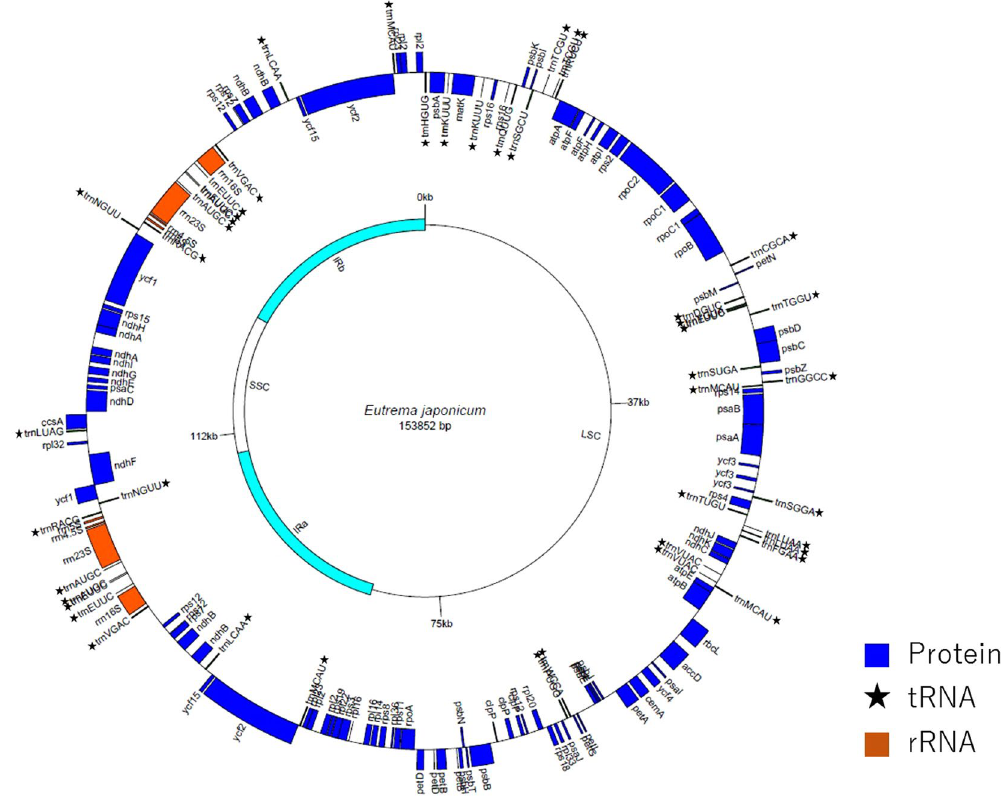
Figure 1. Gene map of Eutrema japonicum ‘Fujidaruma’ chloroplast genome. The genes lying outside the outer circle are transcribed in a counter-clockwise direction, whereas genes inside are transcribed in a clockwise direction. Colors and star marks denote the different functional gene groups. LSC: large single copy, SSC: small- single-copy, IR: inverted